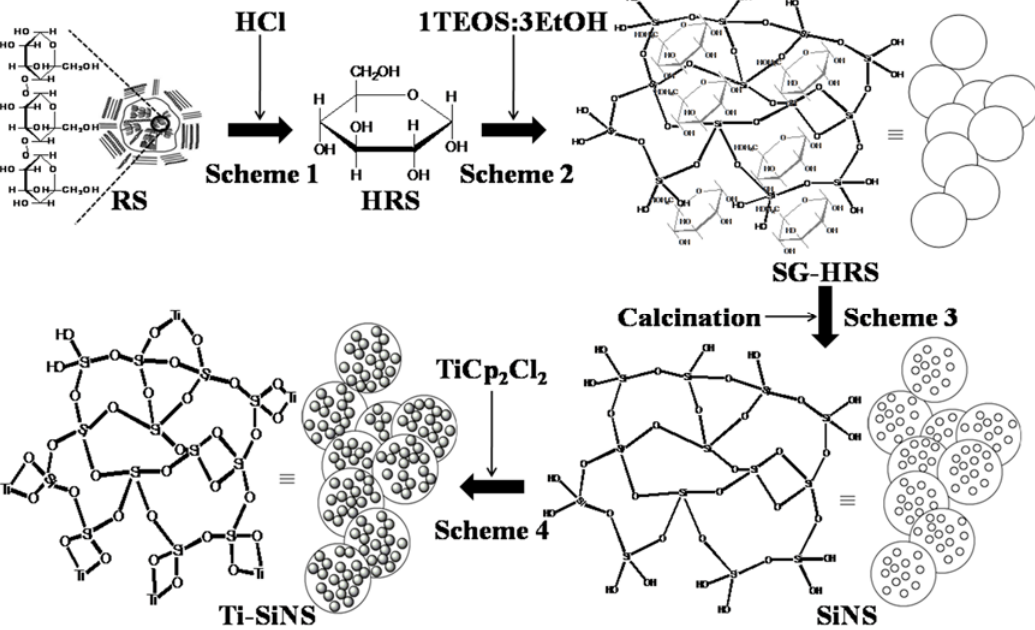
Figure 1. Schemes ( 1 – 4 ) for direct ‐ continuous preparation of nanostructures titania ‐ silica (Ti ‐